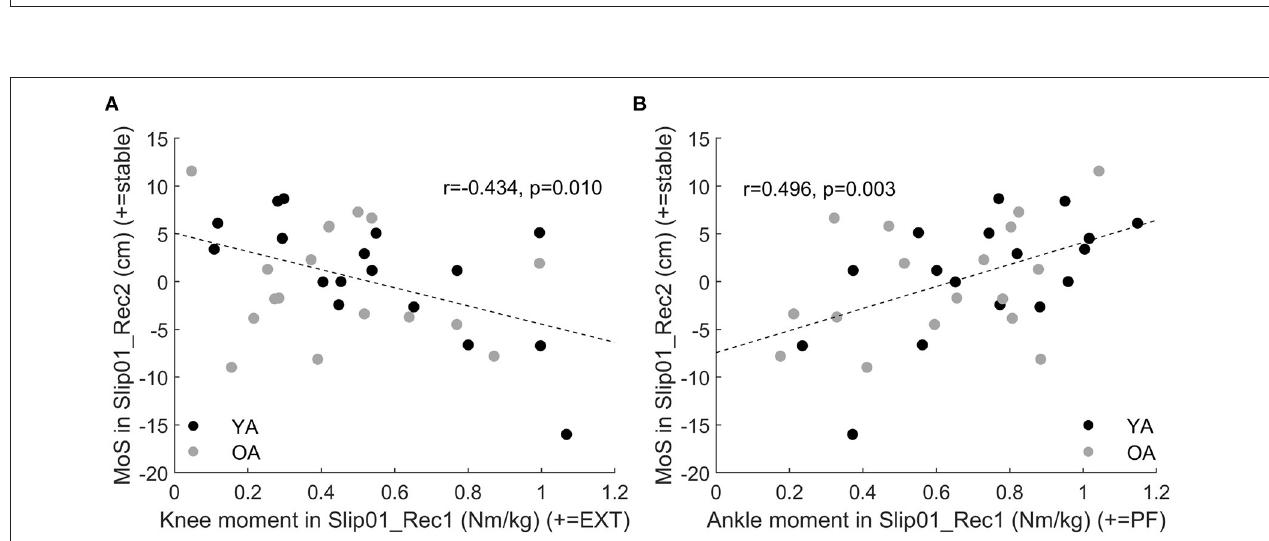
FIGURE 9 | (A) Correlation between knee moment in Slip01_Rec1 from 23 to 79% stance and the MoS of Slip01_Rec2 ( r = − 0.434, p = 0.01). (B) Correlation between ankle moment in Slip01_Rec1 from 37 to 90% stance and the MoS of Slip01_Rec2 ( r = 0.496, p = 0.003). Black circles: young adults; grey circles: older